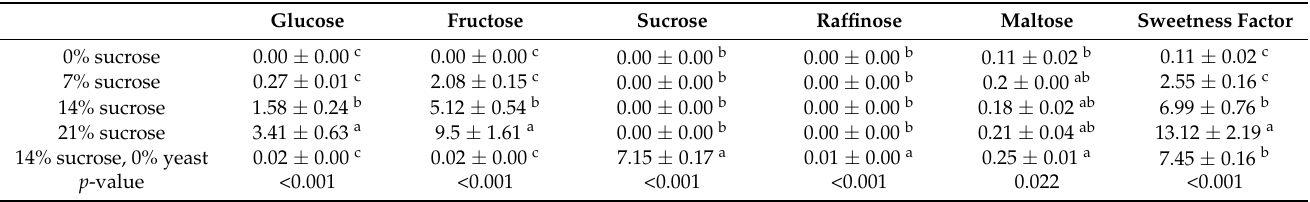
Table 1. The individual calculated sweetness contributions (S A = kC n ) of glucose, fructose, sucrose, raffinose and maltose and the sweetness factor (S = S A + S B + …) for pastry samples with 8% yeast and 0, 7, 14 and 21% sucrose (% w / w dm flour base) and samples with 0% yeast and 14% sucrose. The standard deviations result from duplicate measurements.